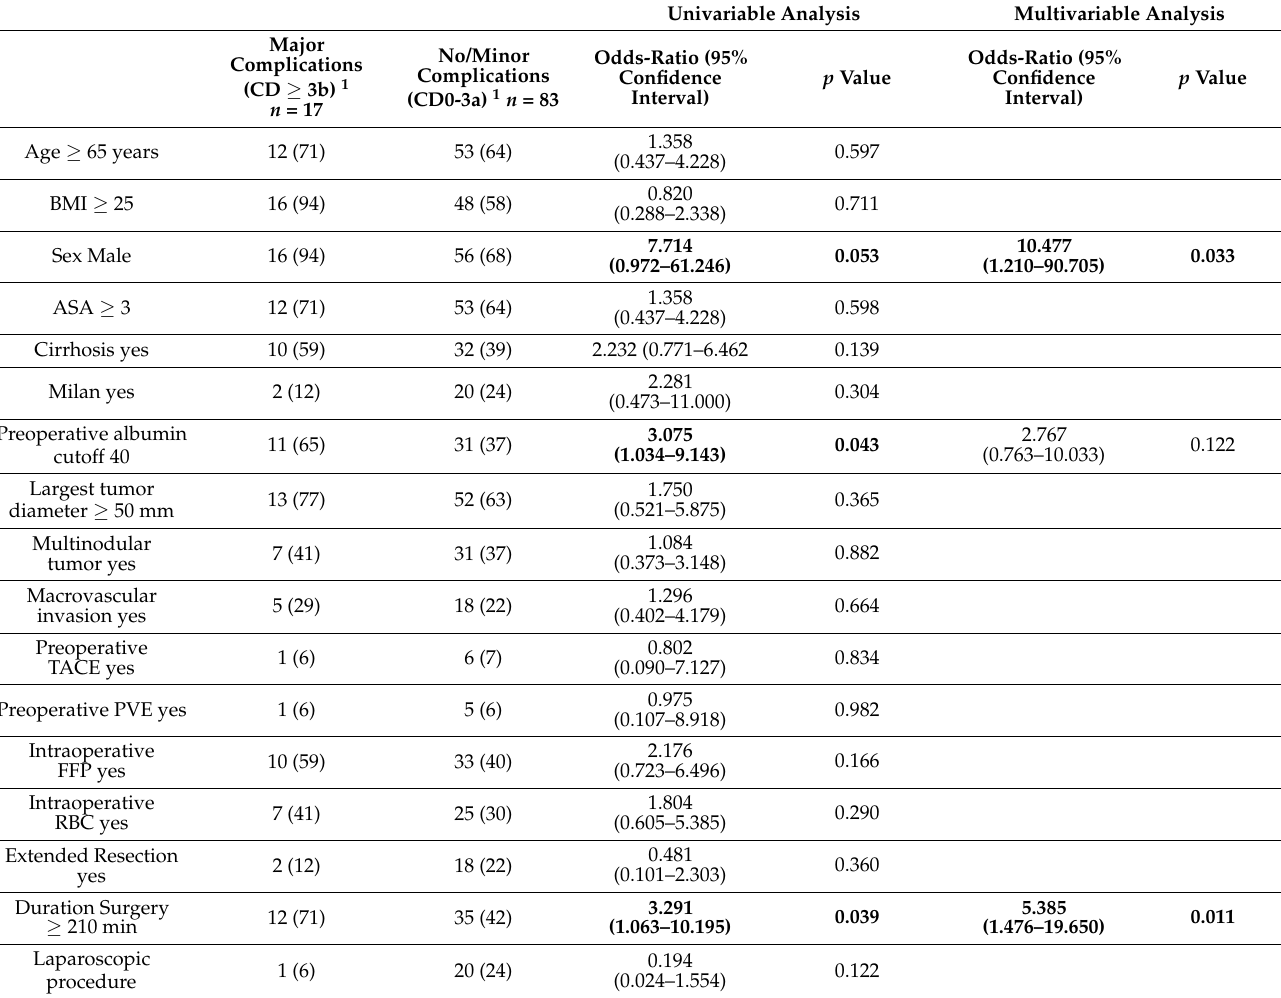
Table 4. Uni- and multivariable logistic regression analysis for 90-day major morbidity (Clavien– Dindo ≥ 3b). Univariable Analysis Multivariable